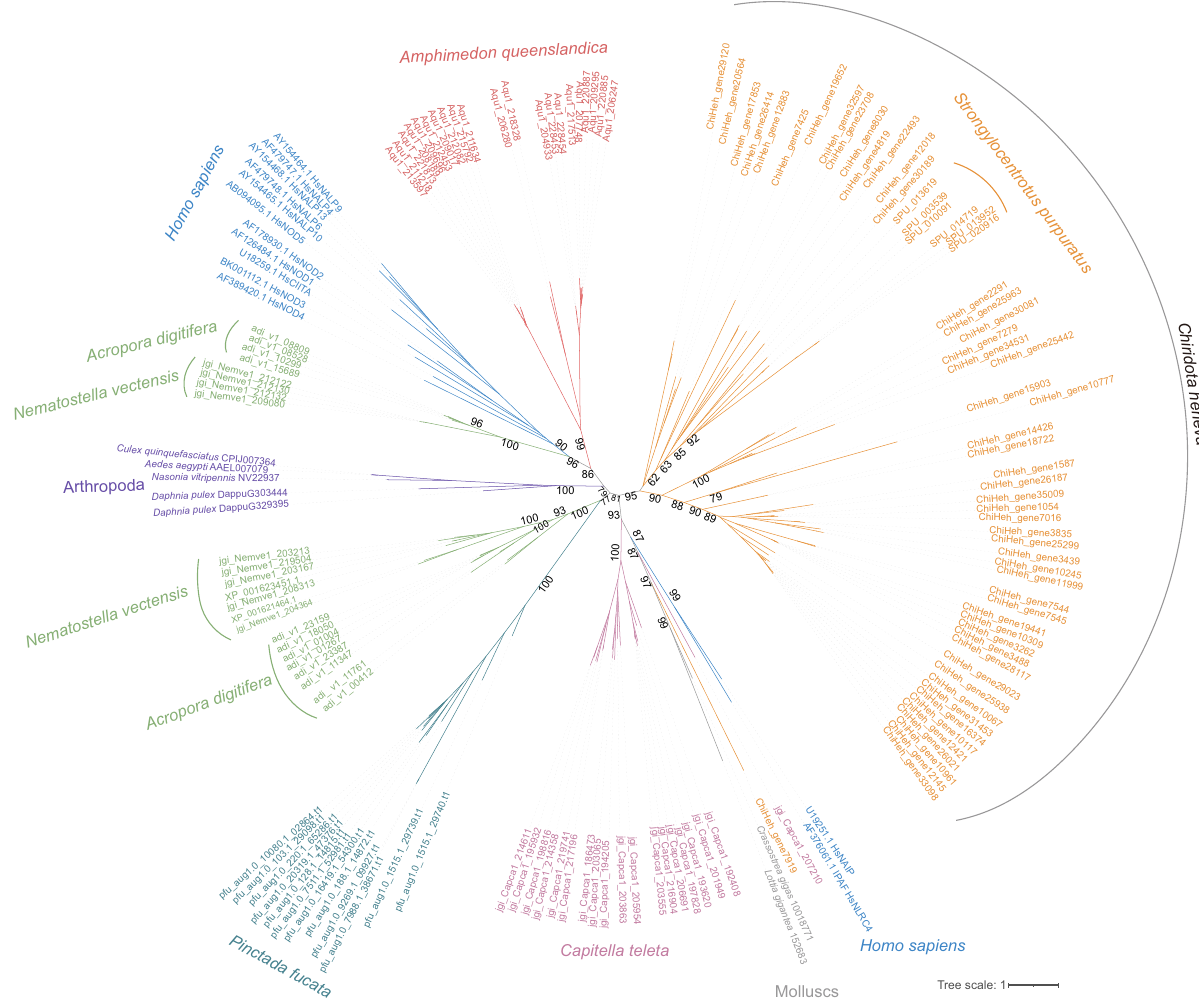
Fig. 4 Evolutionary relationships among C.heheva NLRs and other representative metazoan NLRs. The unrooted phylogenetic tree was reconstructed based on the NACHT-domain sequences using a maximum-likelihood method. The values near the nodes are ultrafast bootstrap (UFBoot) values. NLRs from different types of species are highlighted by branches of different colors. The species name is shown near the corresponding